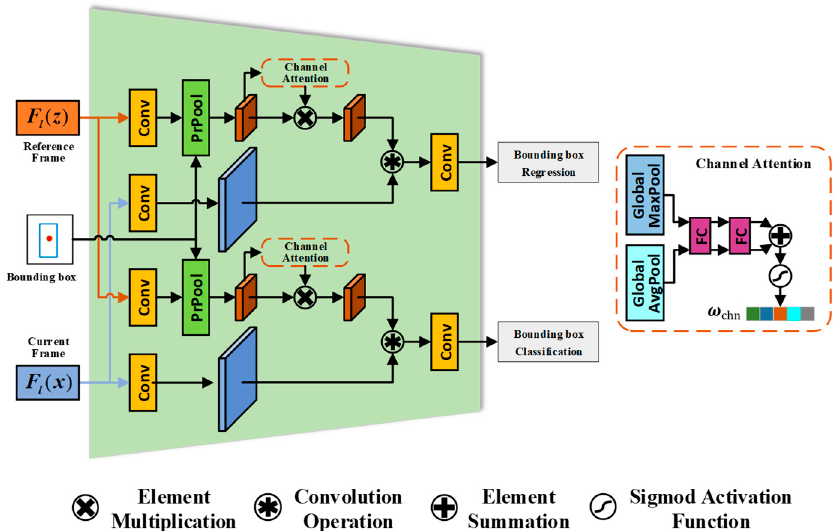
Figure 2. SNN-based RPN structure with channel attention mechanism. The structure includes the branches of bounding box regression and classification. The input is the features of the l -th layer of the reference frame and the current frame. The bounding box regression branch obtains the regression output of the bounding box coordinates, while the bounding box classification branch obtains the classification scores of the target and the background.